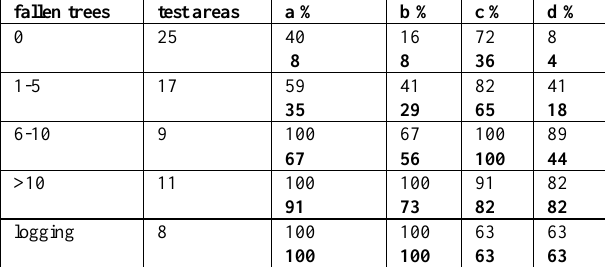
Table 1. Percentage of test squares classified as changed